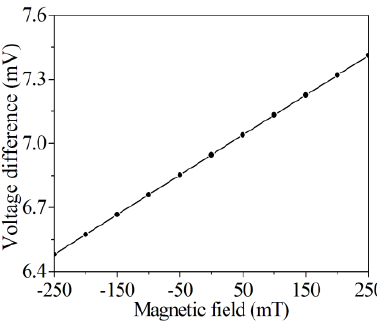
Figure 5. Simulation results of voltage difference of the bases for the